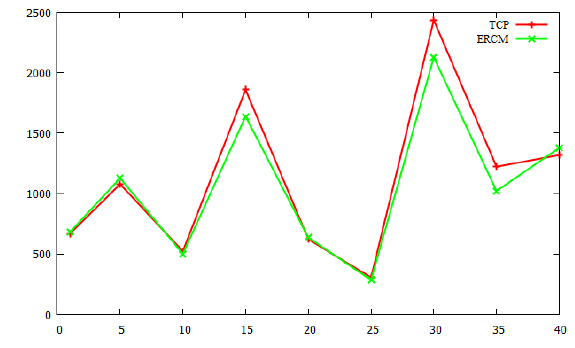
Fig. 7. Congestion loss vs. Mobility for 70 flows